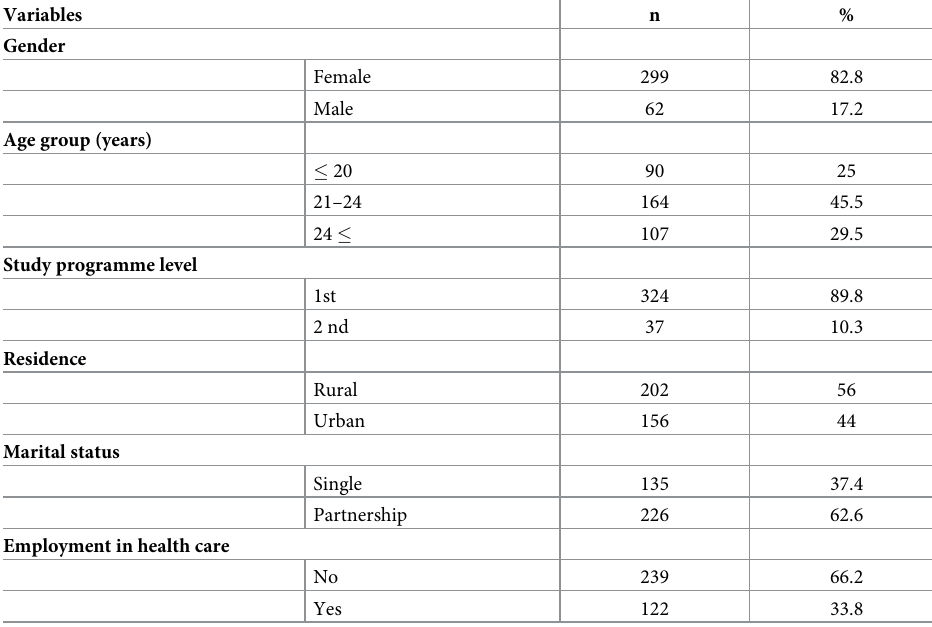
Table 1. Socio-demographic characteristic of study participants (n =